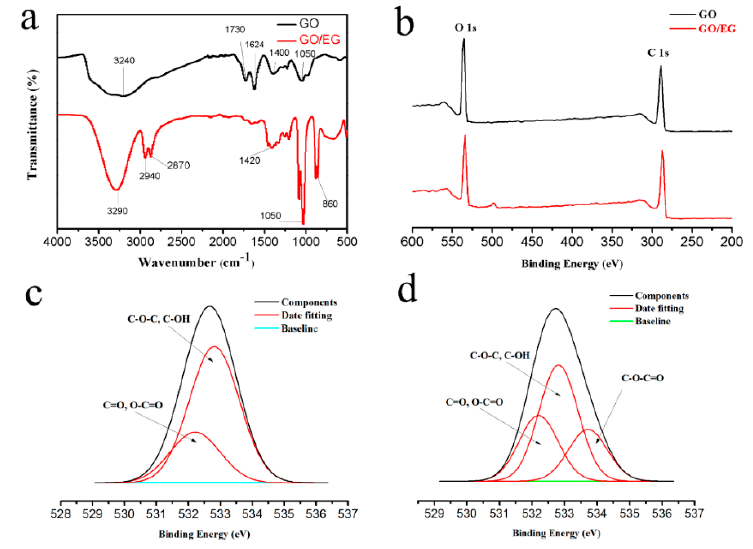
Figure 4. ( a ) FTIR spectra of GO and GO/EG composite; ( b ) survey scans of GO and GO/EG membranes in the spectral region 200–600 eV; ( c ) O 1s region of GO membrane; ( d ) O 1s region of GO/EG membrane.